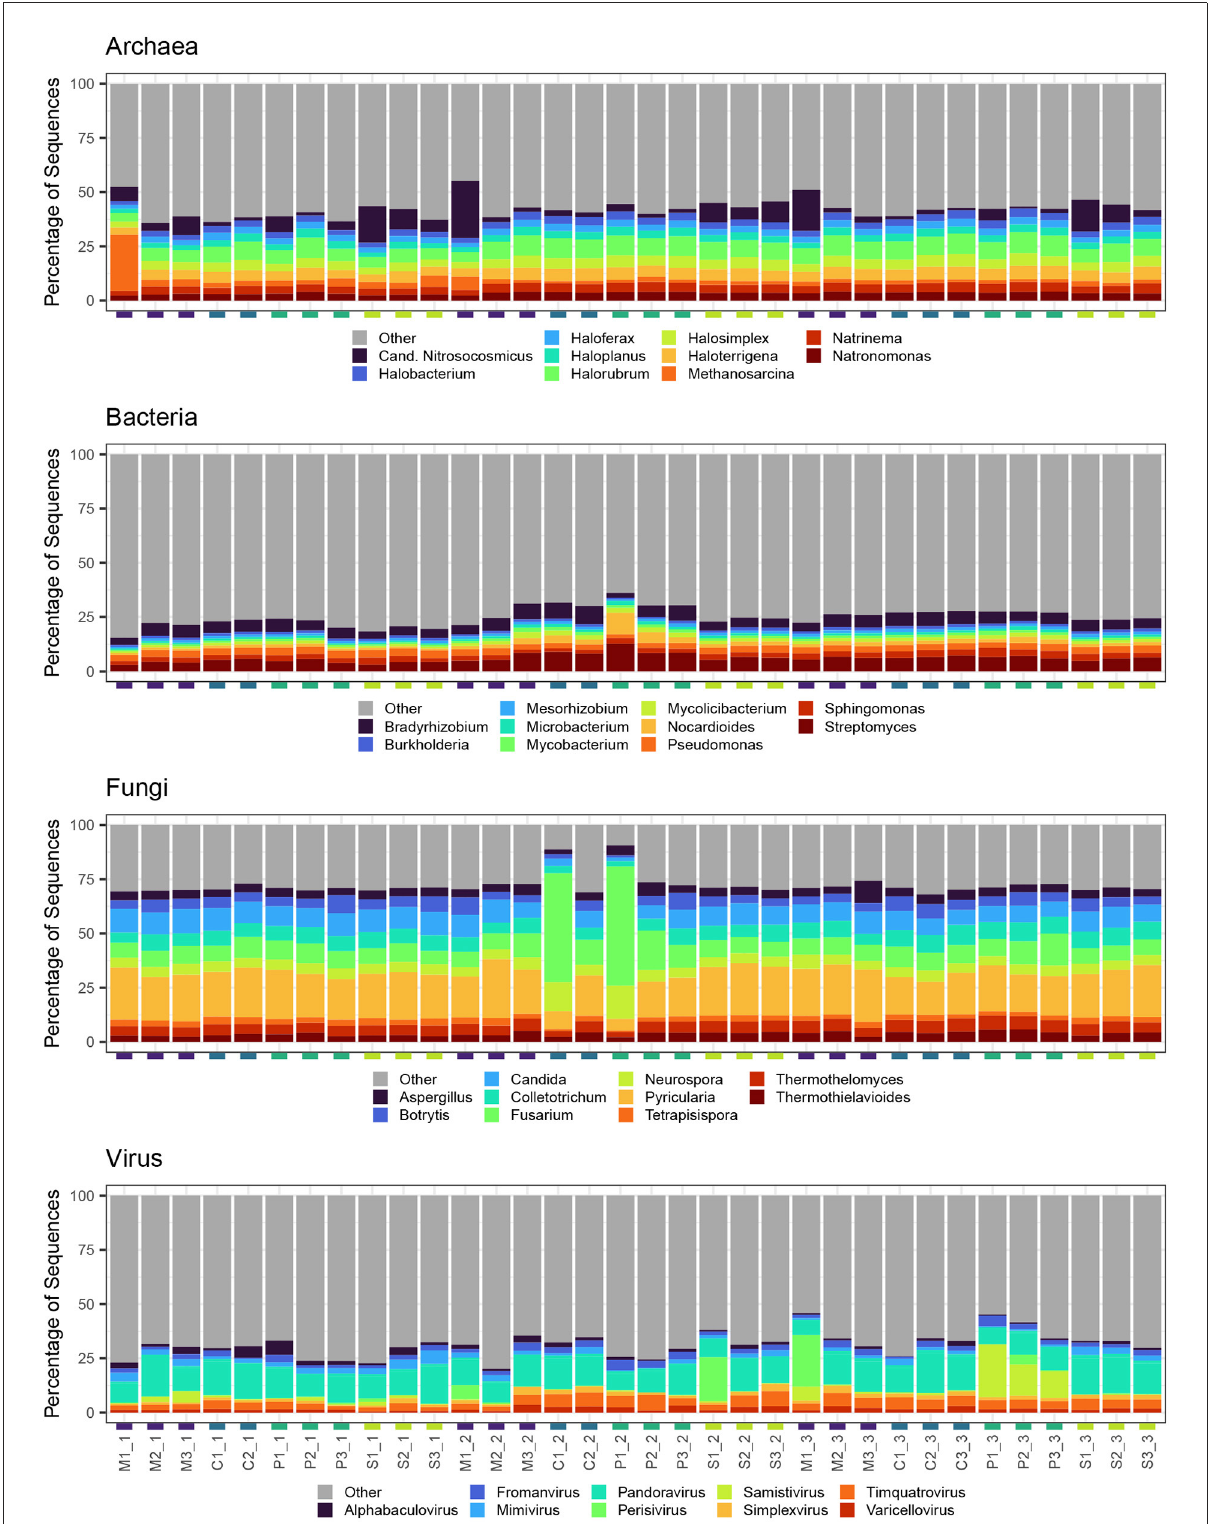
FIGURE5 Top 10 most abundant genera detected in each soil sample for each microbial kingdom. All other genera were aggregated into category “Other.”